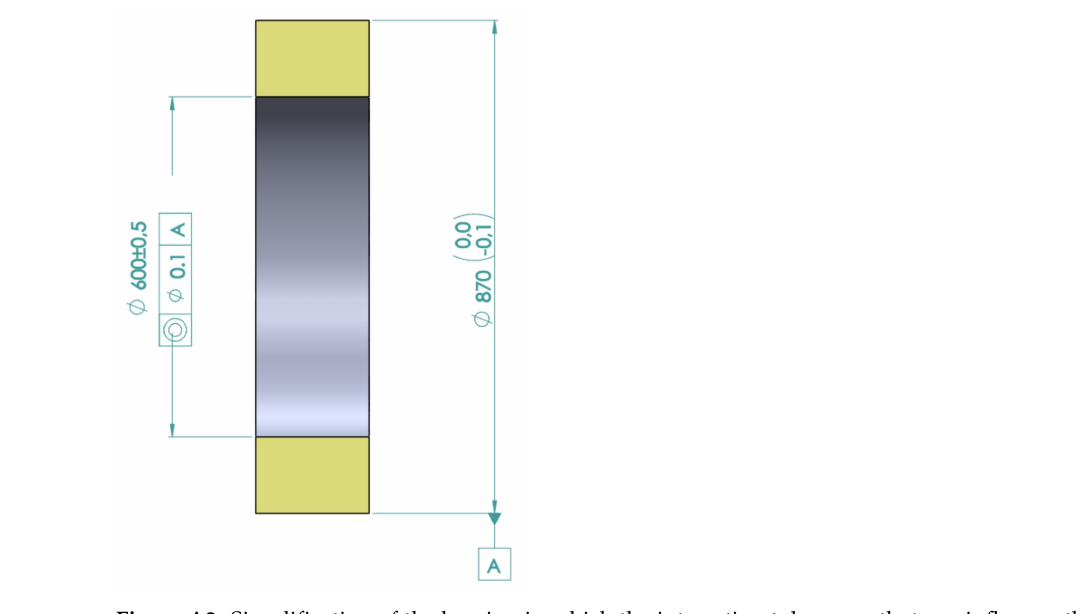
Figure A2. Simplification of the bearing in which the interesting tolerances that can influence the tolerance chain problem are